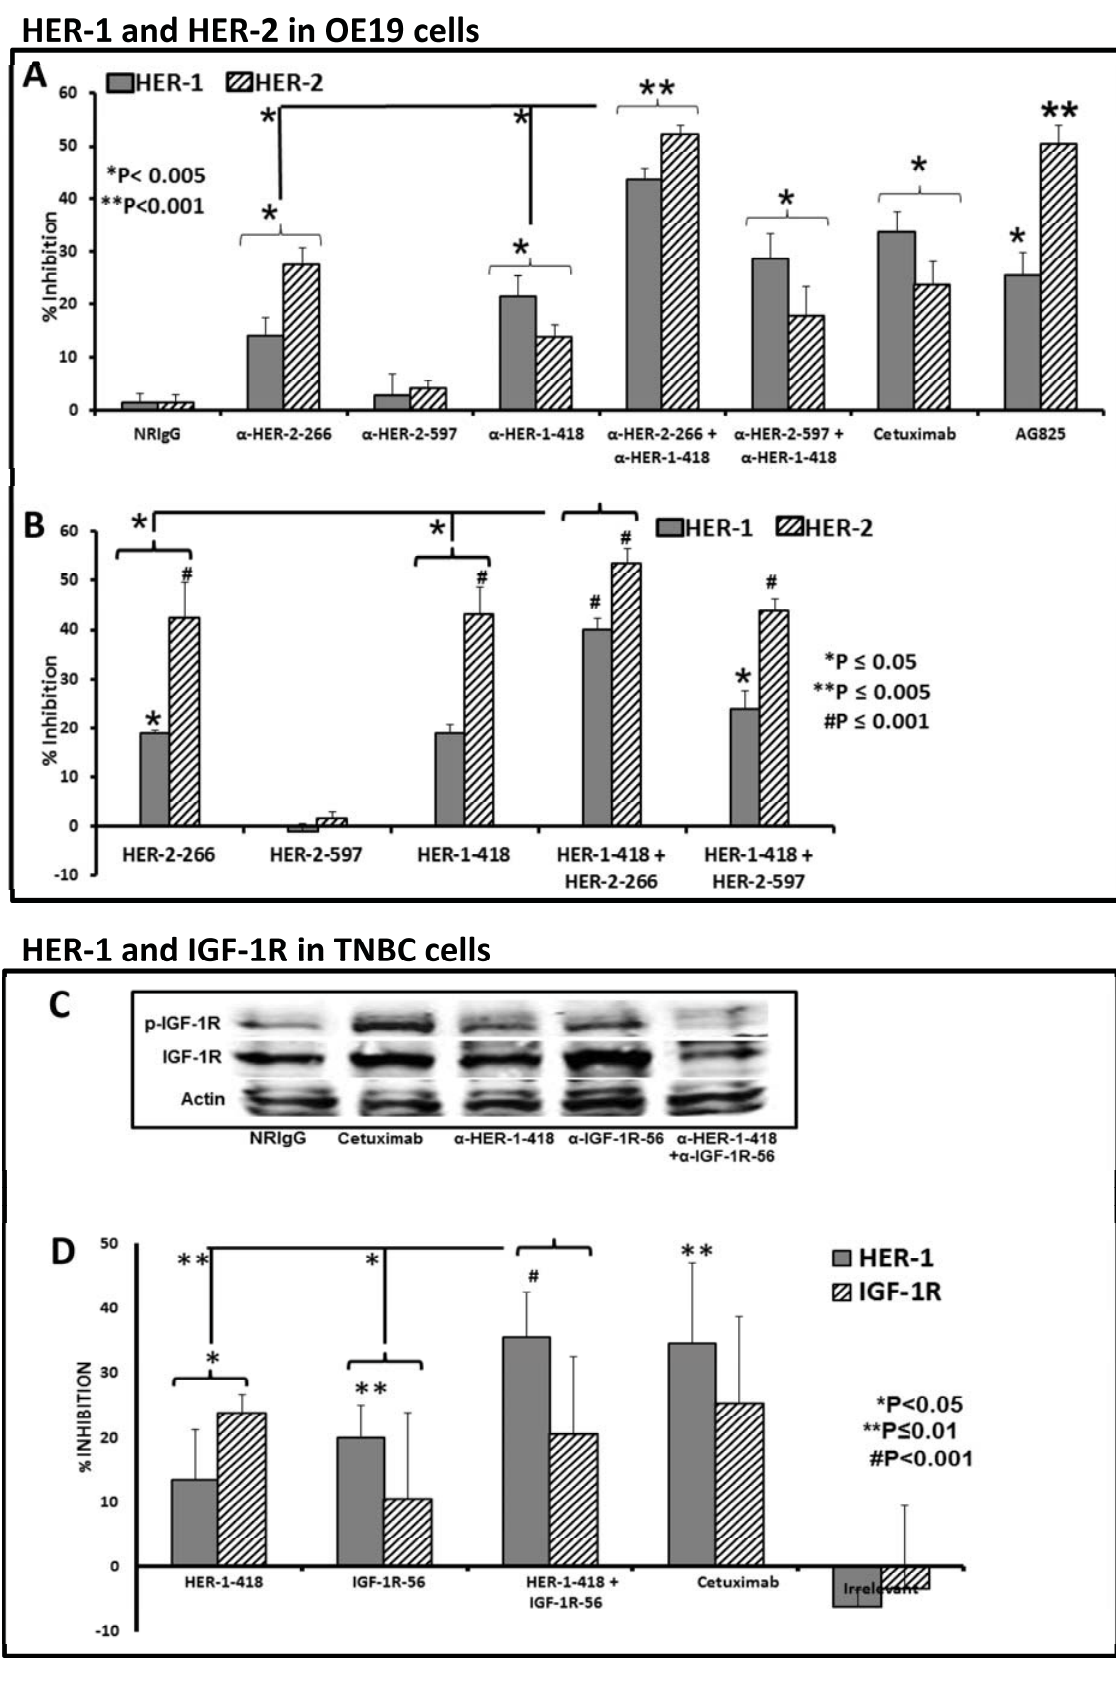
Figure 3. Effects of co-targeting HER-1 and HER-2 or HER-1 and IGF-1R on receptor phosphorylation in EC or TNBC. OE19 or MDA-MB-231 cells were treated for 1 h prior